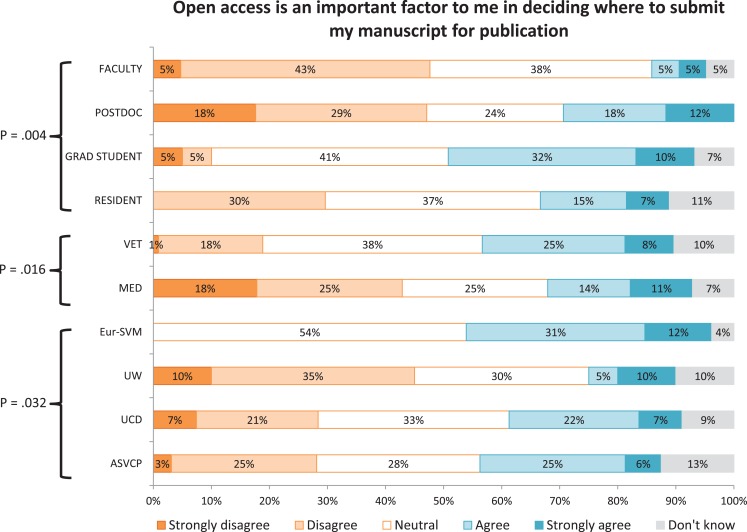
Differences in levels of agreement based on role, veterinary vs medical audience, and site for survey statement #1.